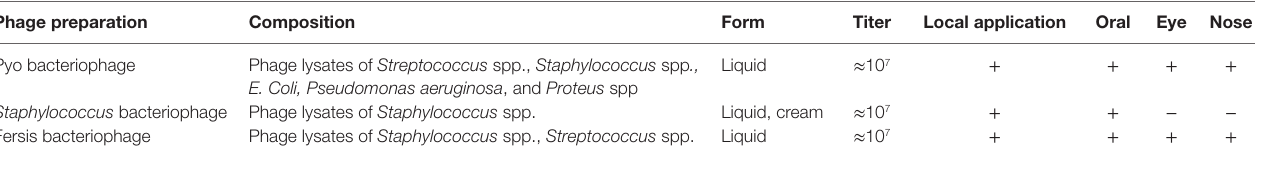
taBle 2 | Bacteriophage preparations (produced by Eliava Biopreparations Ltd.) used for treatment. phage